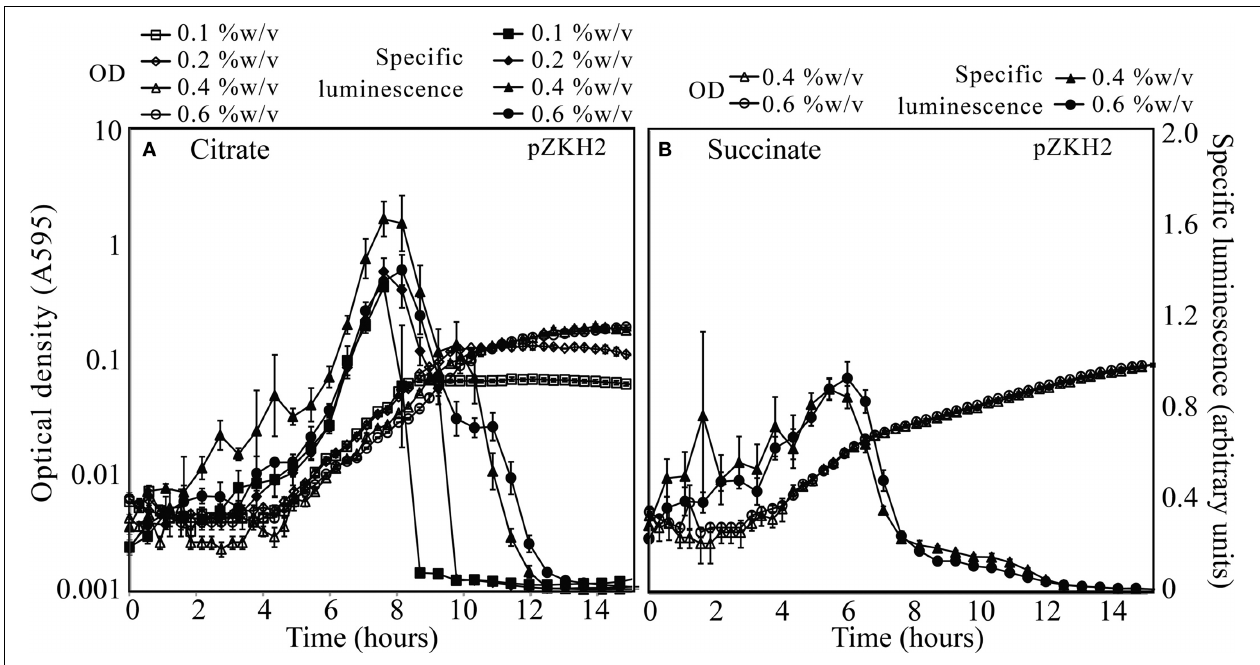
FIGURE 3 | Specific luminescence ( × 10 5 , filled symbols) and optical density (A595, open symbols) from microbiosensor KT2440/pZKH2 during growth in citrate (A) or succinate (B), in 48-well plates. Bacteria